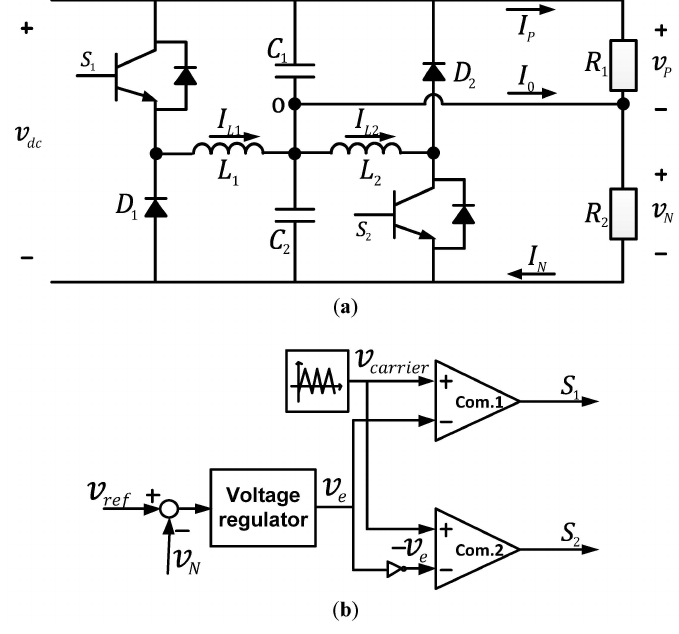
Figure 4. Dual-buck voltage balancer: ( a ) Power circuit; ( b )